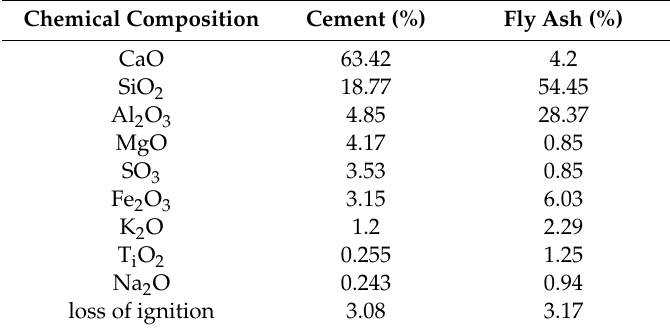
Table 1. Chemical composition of cement and fly ash (wt%).